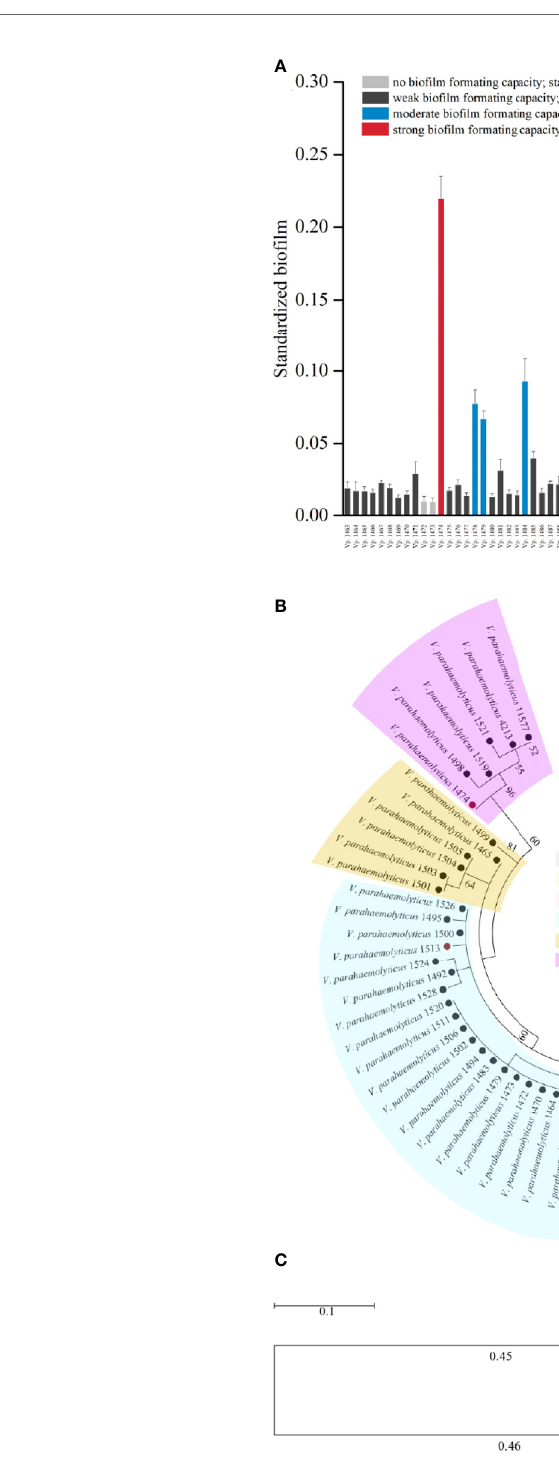
Frontiers in Cellular and Infection Microbiology |